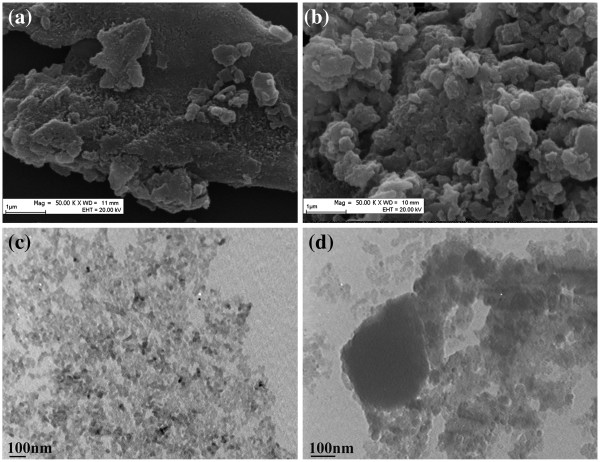
TEM and SEM images of PANI(HAuCl4·4H2O) and PANI(H2PtCl6·6H2O). (a) SEM and (c) TEM images of PANI(HAuCl4·4H2O); (b) SEM and (d) TEM images of PANI(H2PtCl6·6H2O).